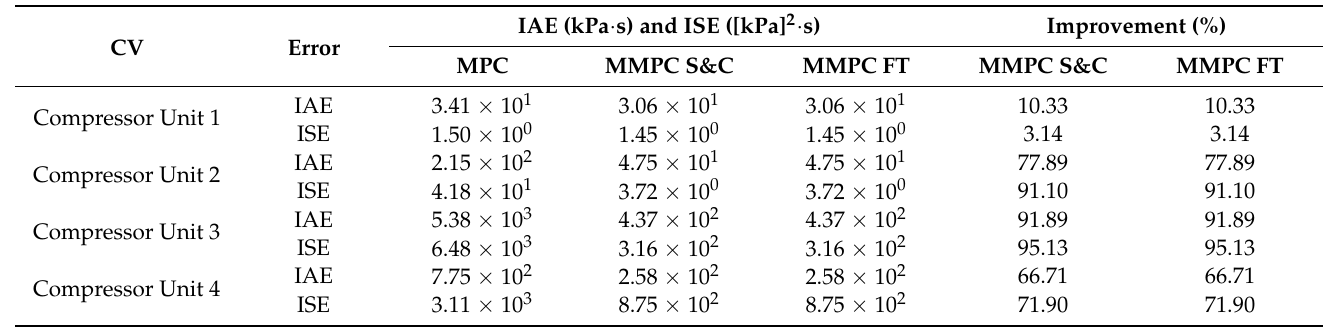
Table 14. Comparison of IAE and ISE on the compressor unit with changes on compressor unit 4 (MIMO Model 2).